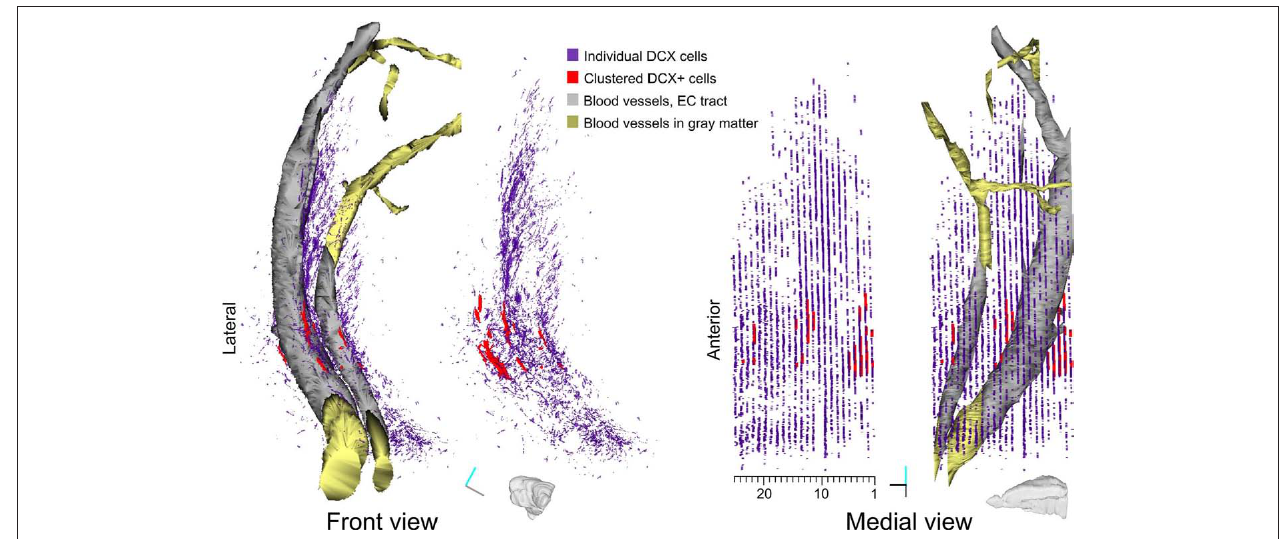
through the EC (gray and gold). Tracts of the blood vessels running in the EC or in the gray matter are depicted as separate Boissonnat surfaces colored in gray and golden respectively. Both DCX + staining and clustered DCX + cells are represented as traces slabs. A scale indicating the number of individual sections in the reconstruction is shown under the medial view of the model. Orientation Bars: gray line: medial; cyan line: dorsal; dark line: